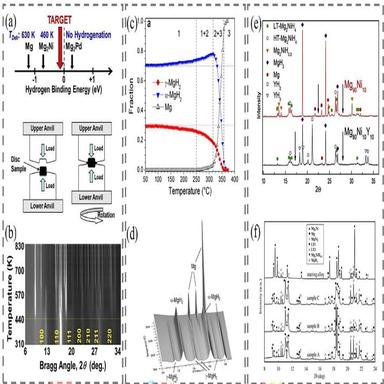
Diffraction mapping of Mg alloys for hydrogen storage: (a, b) the hydrogen binding energy effects and HPT method by in-situ synchrotron radiation during heating ; (c, d) phase fractions calculated from the in-situ SR-XRD patterns of the thermal decomposition ; (e, f) SR-XRD patterns after activation and hydrogenation .